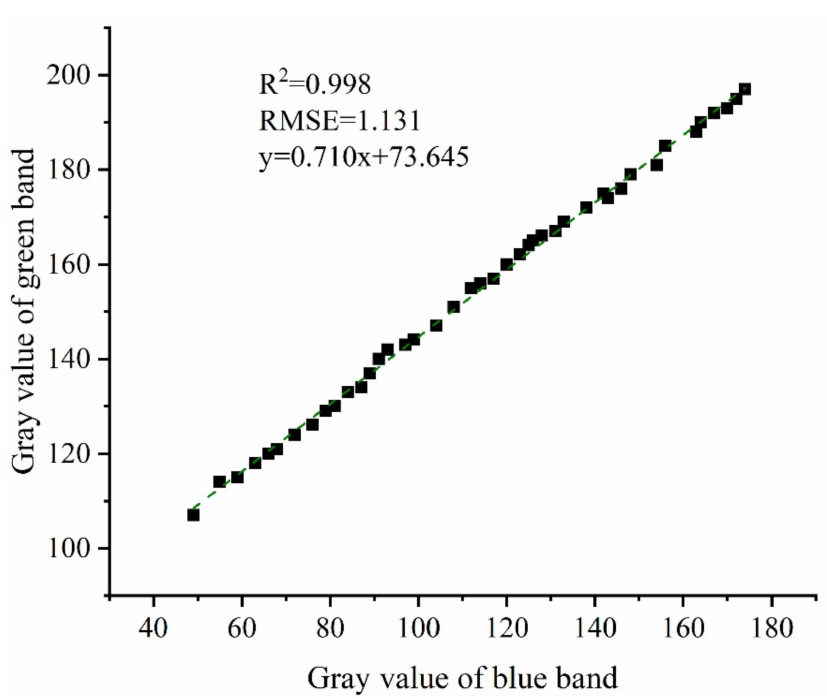
Figure 7. Fitting results of the green band and blue band for potato plant leaves.